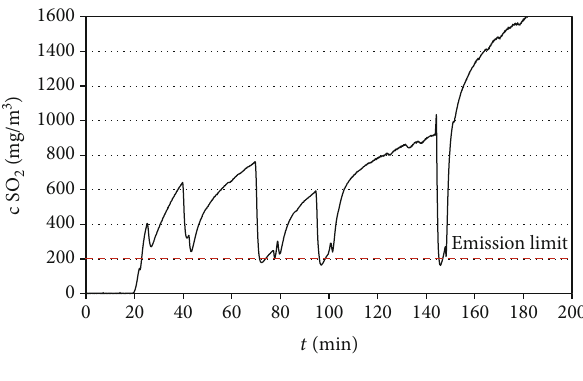
Figure 4: The breakthrough curve of sample 3.